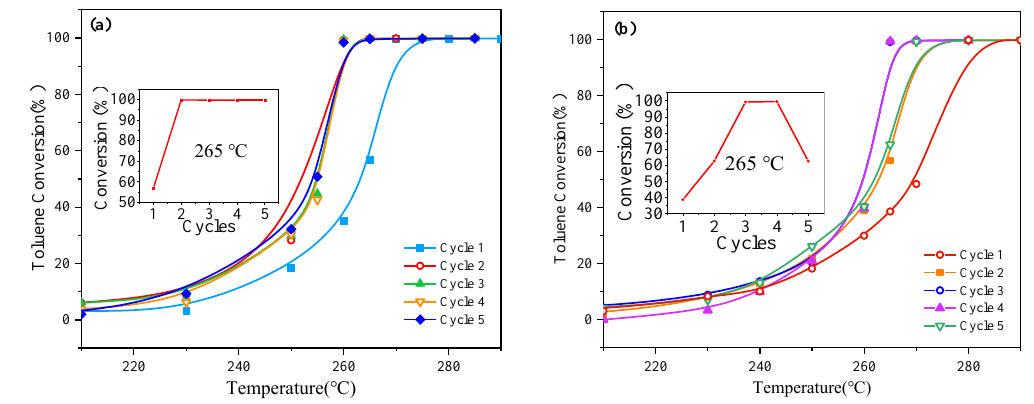
Figure 7. Activity cycle test of the TP-Mn2Zr3 catalyst ( a ) and the CP-Mn2Zr3 catalyst ( b ).